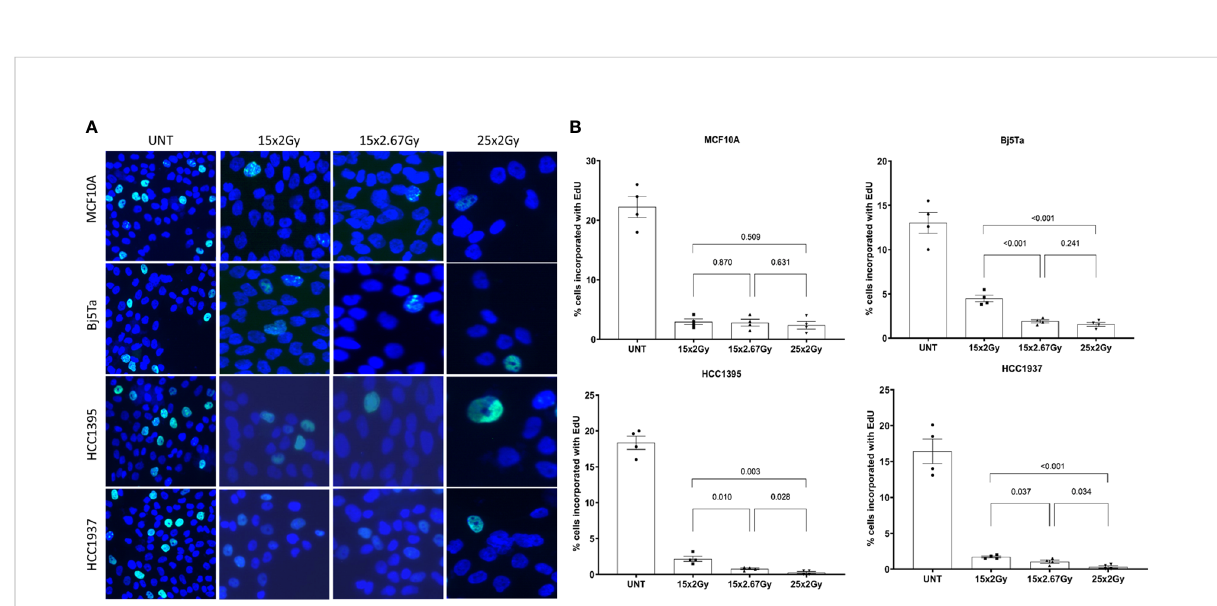
FIGURE 3 DNA synthesis-based cell proliferation evaluated on irradiation day 15 (both protocols) and on day 25 (NormRT only). Representative images of EdU incorporation staining (A) using conventional fl uorescence microscopy (Leica DMI6000B) and evaluation (B) . The percentage of EdU-positive cells is presented as a bar plot +/- SEM.